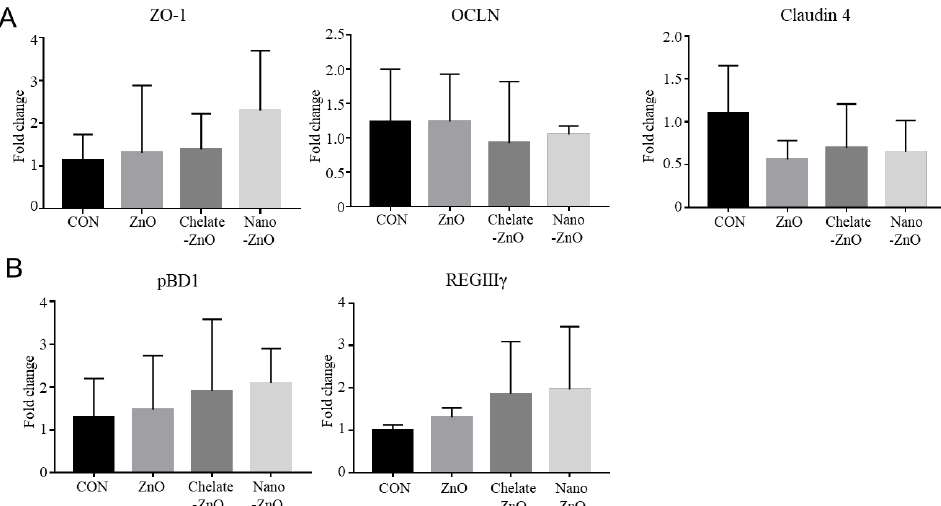
Figure 8. Barrier function in the colon tissues of weaned piglets fed different forms of zinc oxide. The gene expression of barrier functioning ( A ) and antimicrobial peptides ( B ) in colon tissues are shown. The mRNA expressions of the tight-junction related genes, ZO-1, OCLN, and CLDN4, were analyzed. The mRNA expressions of the antimicrobial peptide genes pBD1 and REGIII γ were analyzed. Gene expression levels of each group were calculated based on that of the negative control group (CON). All fold change values were normalized by GAPDH. Data are represented as mean ± SD. Values were statistically analyzed by one-way ANOVA with Tukey ’ s multiple comparison test.